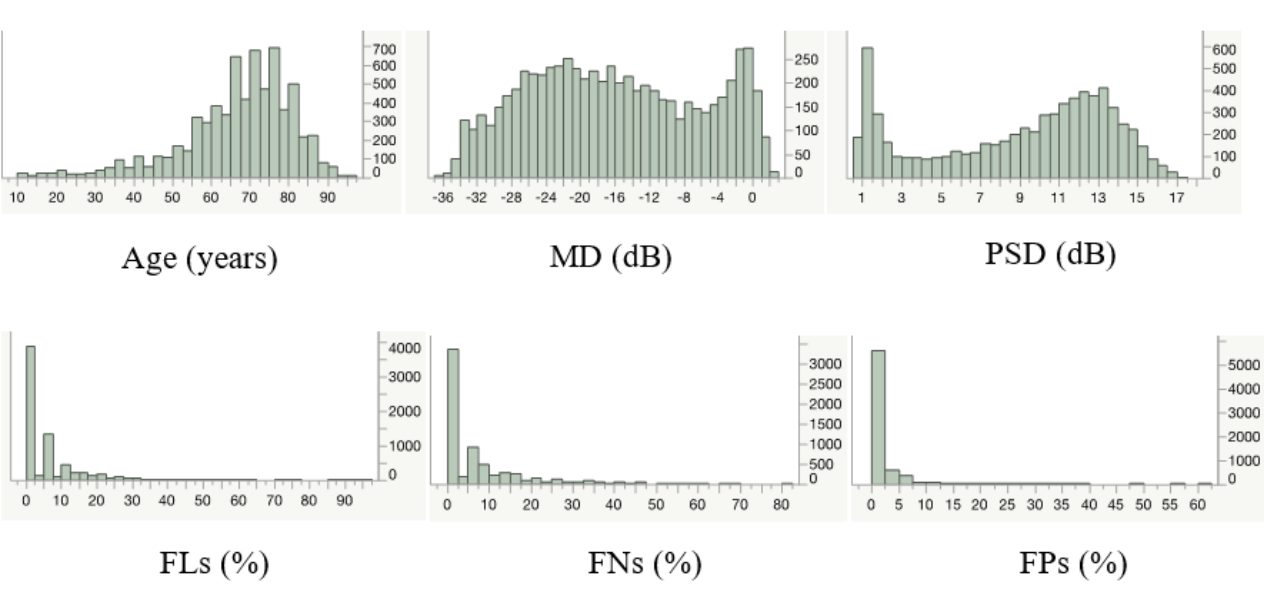
Figure 1. Distribution of the parameters.